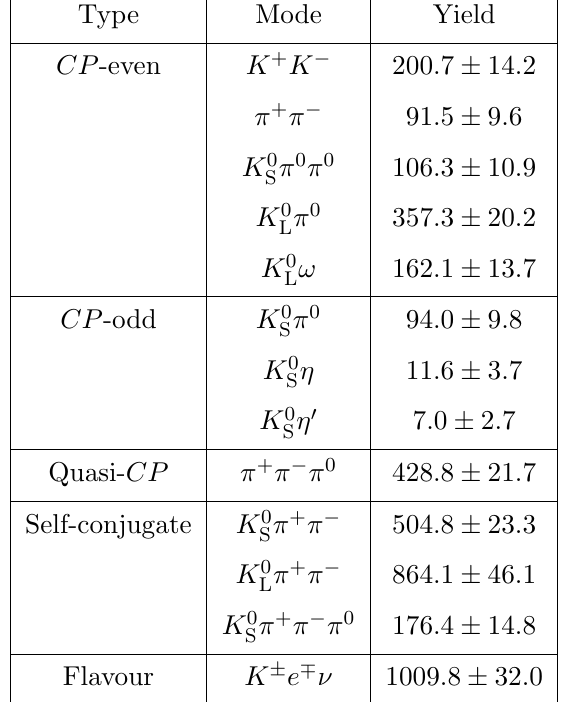
(cid:25) + (cid:25) (cid:0) against D ! L (cid:25) (cid:6) S ; L